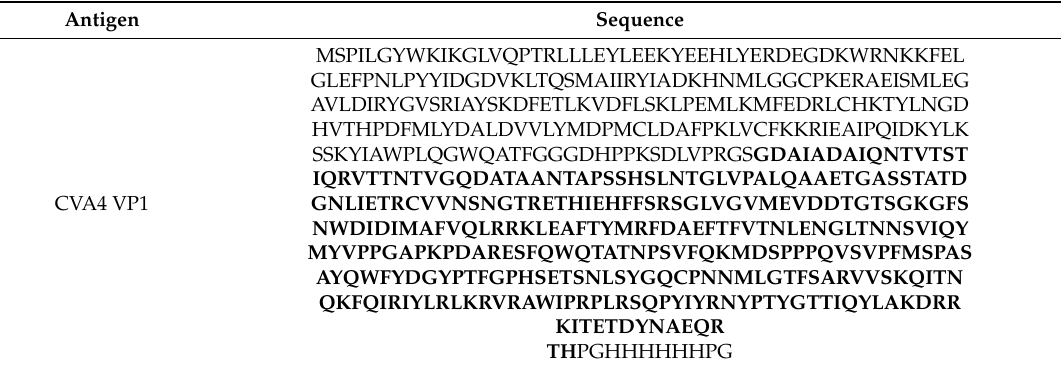
antigen are typed in